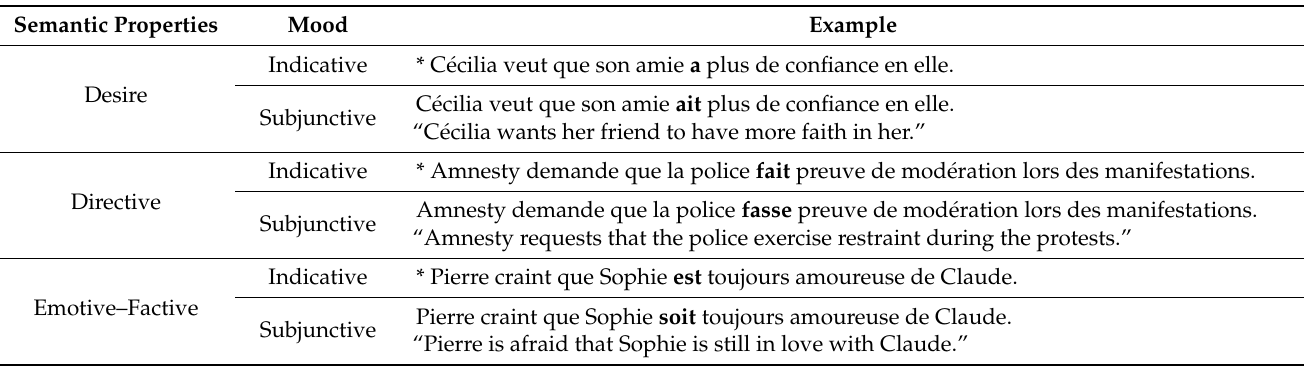
Table 2. Example test